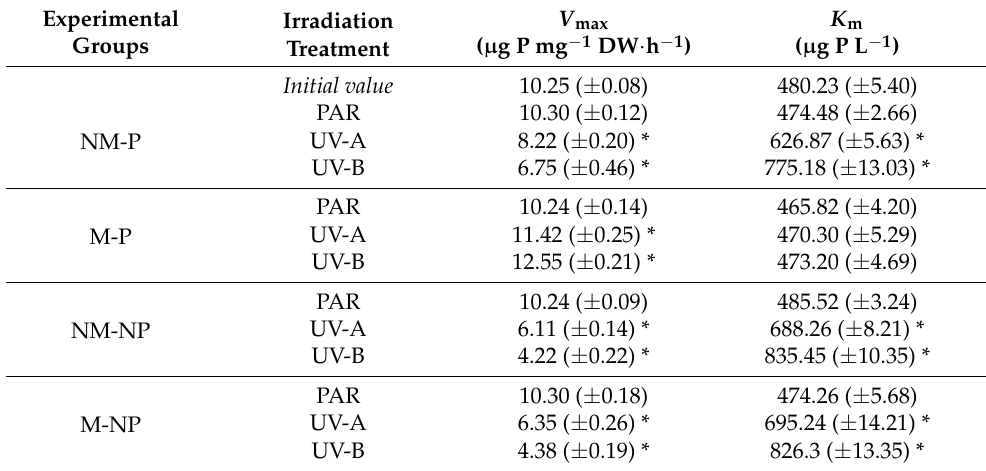
Figure 4. Contents of ( a ) chlorophyll a, ( b ) carotenoid and ( c ) phycocyanin in single cells after 5 h of different irradiation (Arrows indicate the initial values of photosynthetic pigment). Table 1. Kinetic parameters for DOP uptake by M. aeruginosa after 5 h of irradiation (* indicates a significant difference between treatments and the initial value at p <